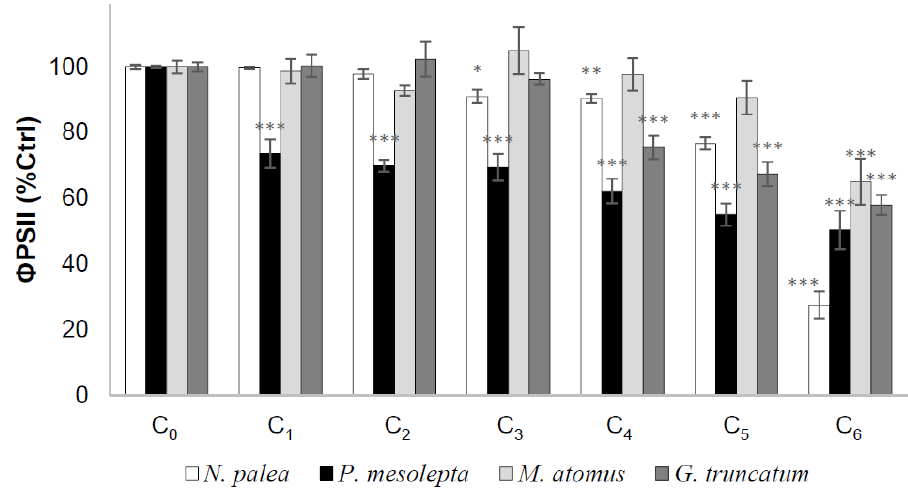
Figure 2. Mean e ff ective quantum yield (percentage of the control (Ctrl), ± standard error) as a function of Cd concentration for N. palea , P. mesolepta , M. atomus , and G. truncatum after 19 h of exposure to Cd ( n = 3, * p < 0.05, ** p < 0.01, *** p < 0.001).